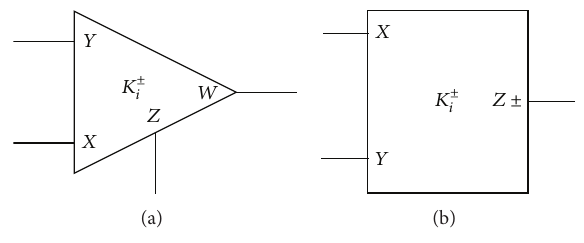
Figure 2: Symbol of (a) DPCFA and (b) DPCCII.